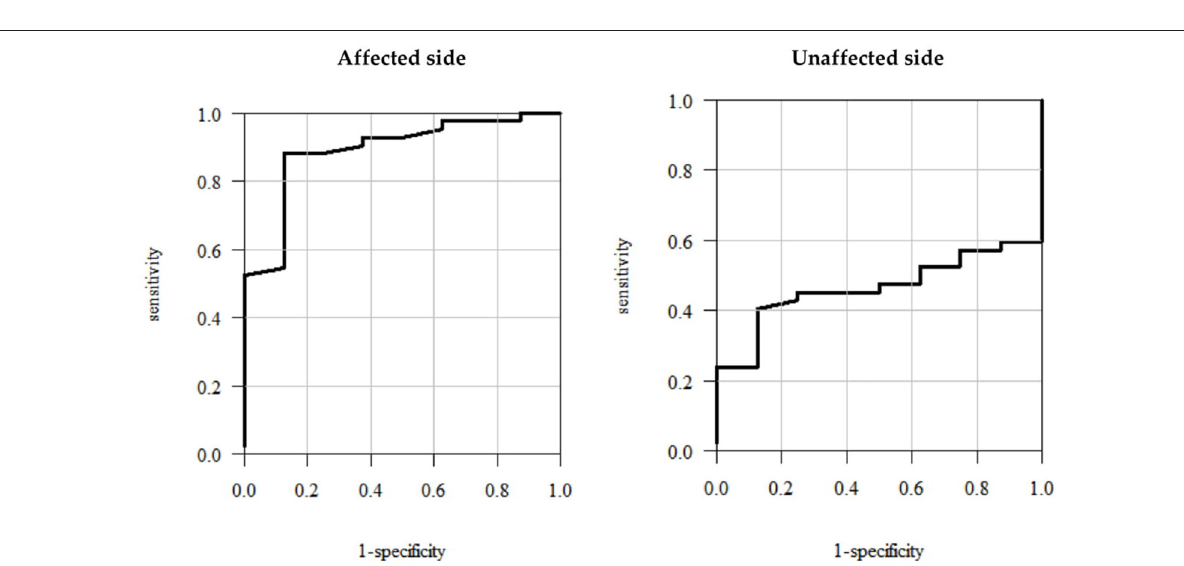
FIGURE 3 | Receiver operating characteristic (ROC) curves—plots illustrating sensitivity vs. 1-specificity values for the hip FE ROM for the affected/unaffected